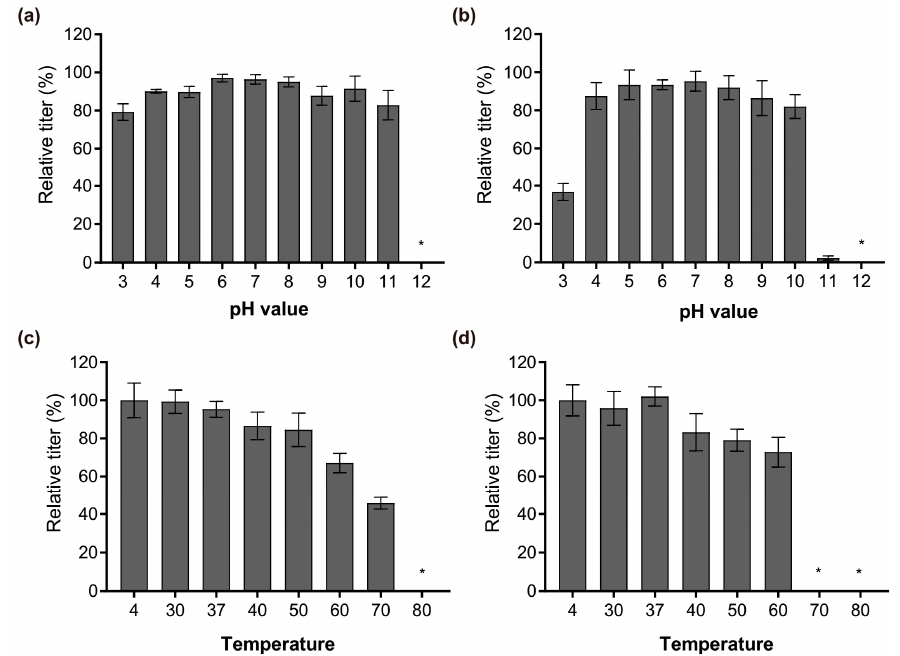
Figure 6. Relative amount of infectious phage particles after different treatments. ( a ) vB_PaeM_SCUT-S1 and ( b ) vB_PaeM_SCUT-S2 incubated for 1 h at different pH levels; ( c ) vB_PaeM_SCUT-S1 and ( d )